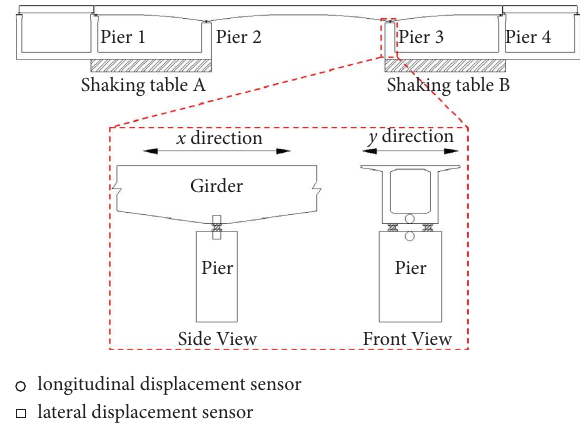
Figure 9: Arrangement of sensors in the x and y direction.